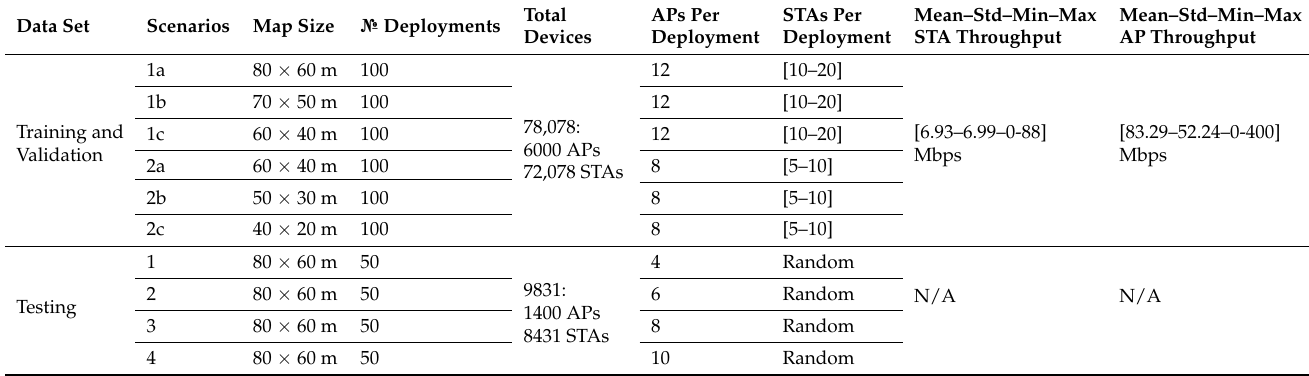
Table 1. Summary of data set